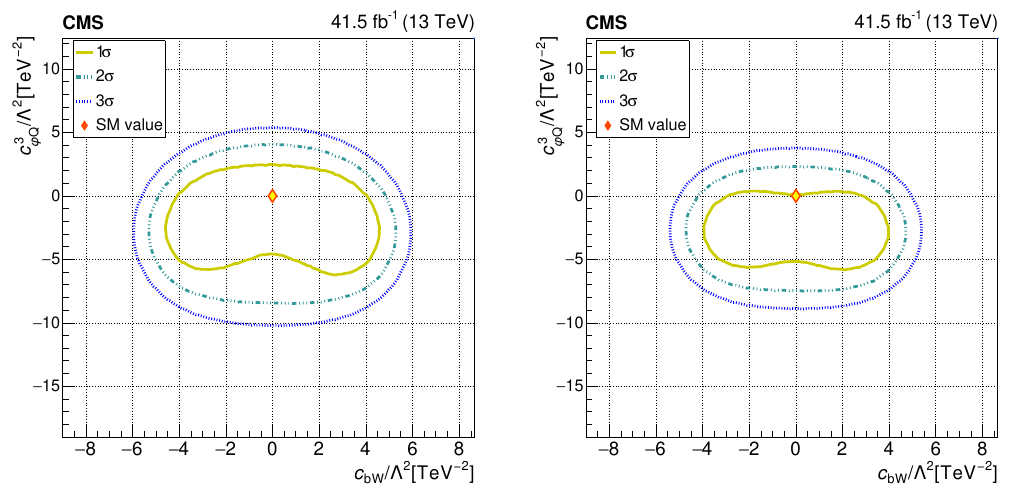
and c with ϕQ bW